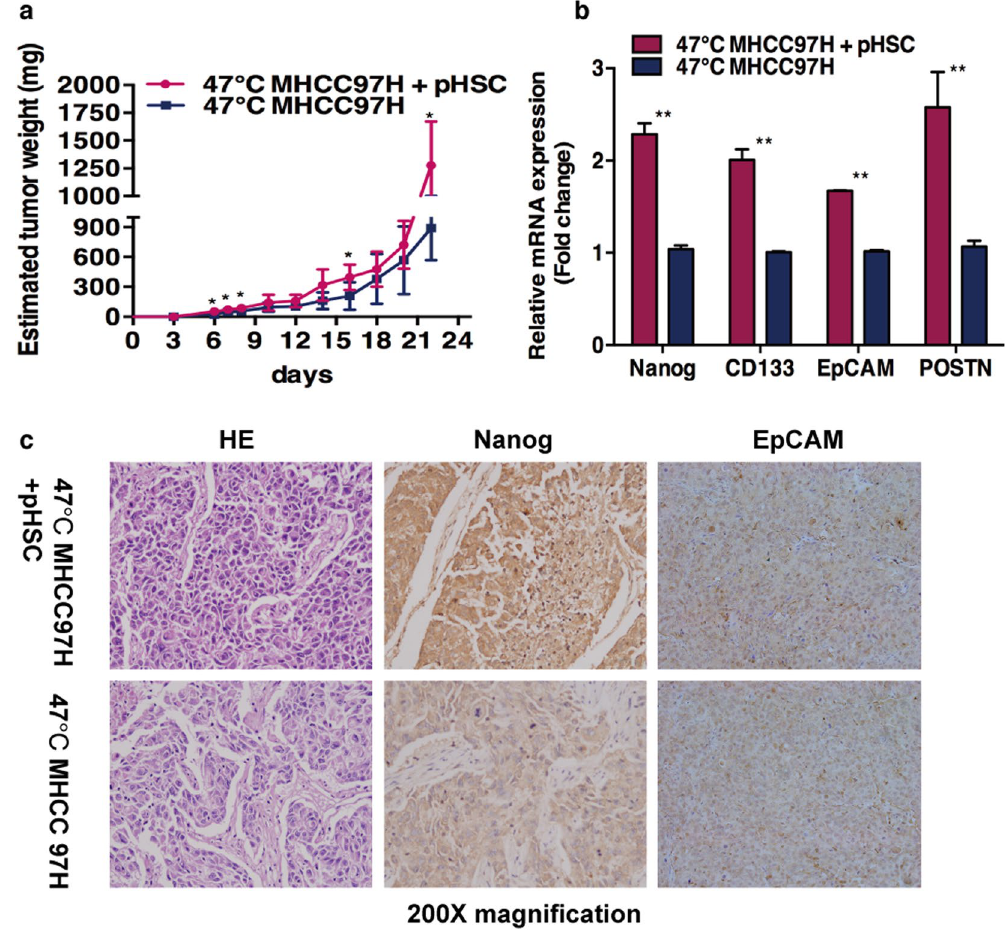
Figure 4. Activated HSCs promote the in vivo progression of heat-exposed residual HCC cells. ( a ) Heat- exposed residual MHCC97H cell co-inoculated with or without activated HSCs subcutaneously in the right flank of nude mice (n = 6 mice per group). The group of residual MHCC97H with pHSCs displayed faster tumor growth as assessed by estimated tumor weight (ETW) compared to the residual MHCC97H group. ( b , c ) Up-regulation of Nanog, CD133, EpCAM and POSTN in the tumors generated with residual MHCC97H with pHSCs. Quantitative RT-PCR and immunohistochemical analysis were performed. ** P < 0.01; * P <